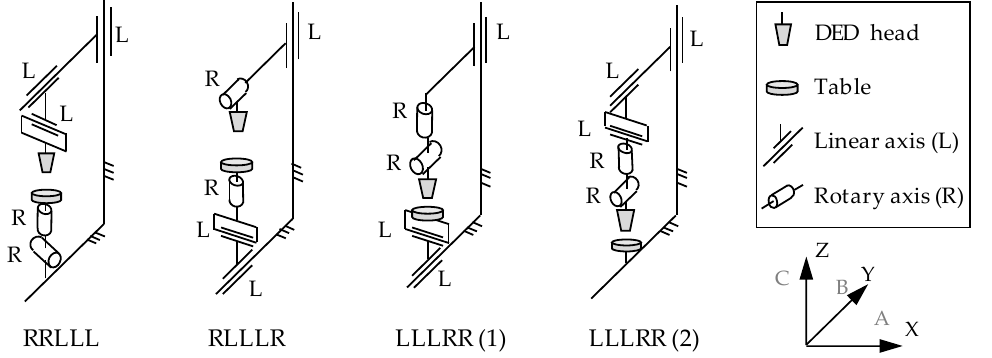
Figure 4. Most common kinematic schemes of hybrid machines.